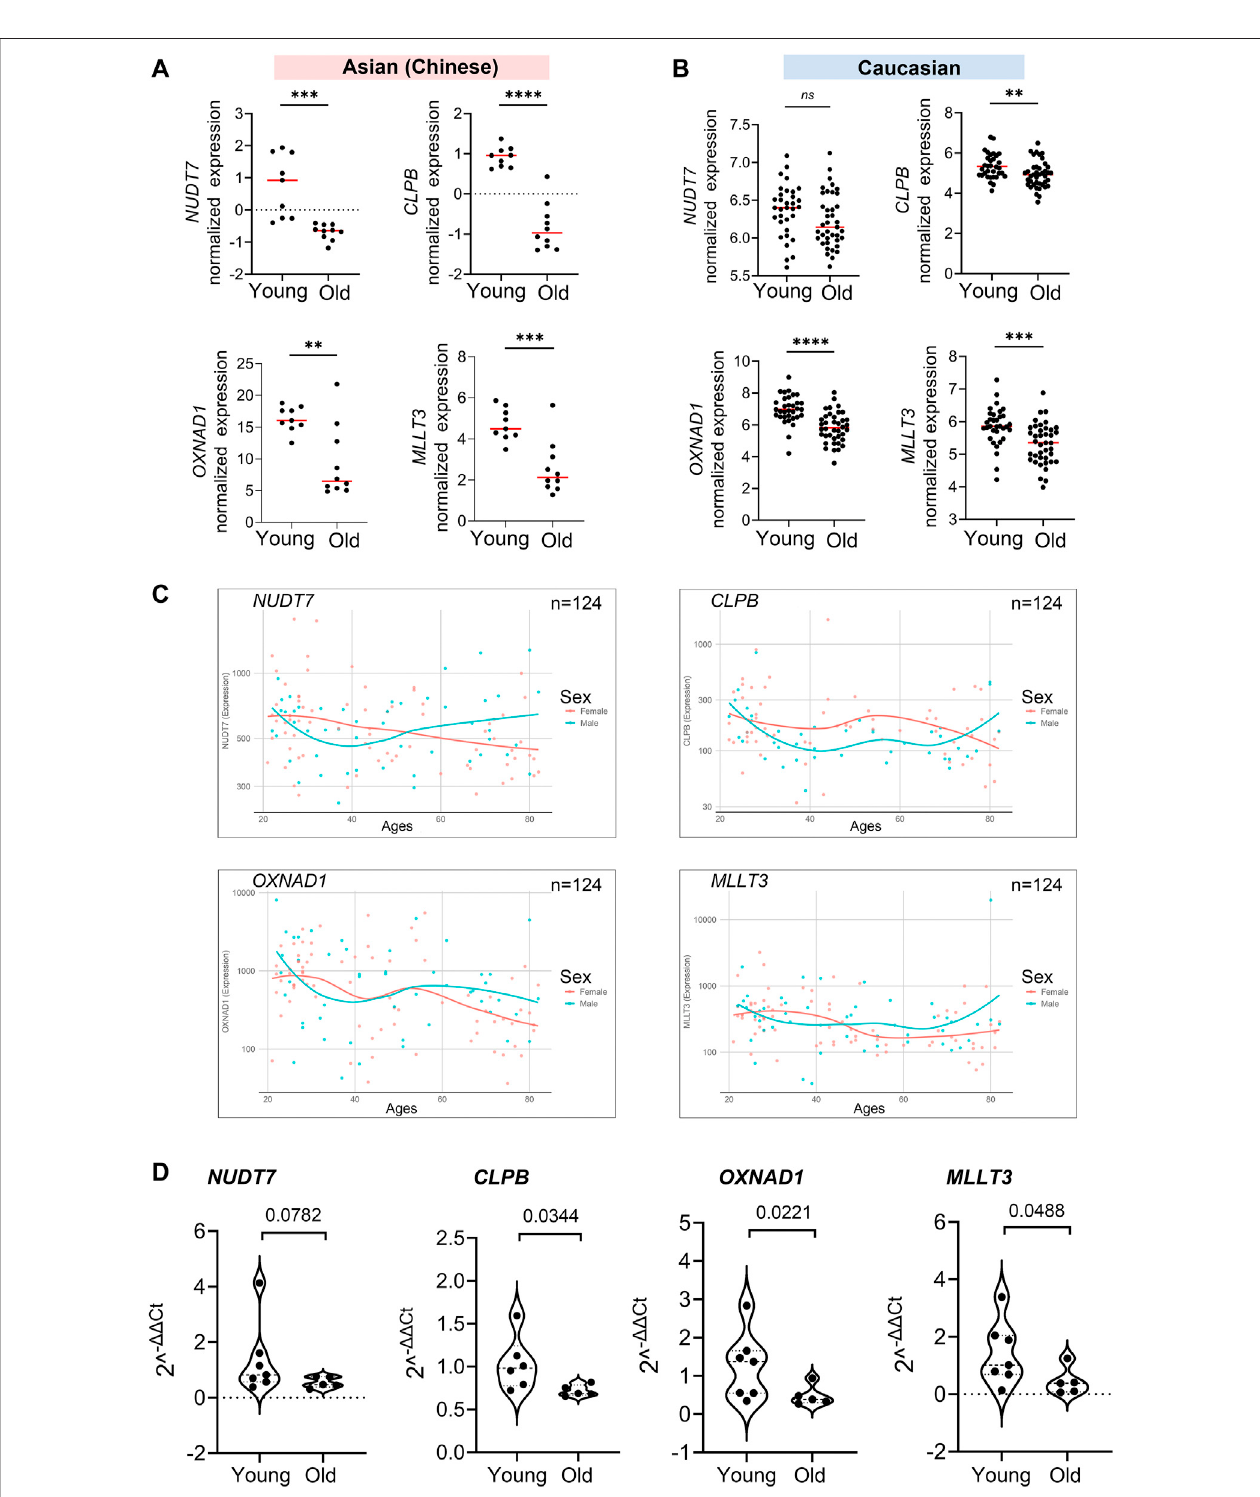
FIGURE 7 | Validation of expression levels of the common hub genes involved in PBMC aging. The validation in Asian (Chinese) and Caucasian was performed using additional samples and 10KIP data, respectively. (A,B) Gene expression value of the hub genes among young and old samples in 19 Asian (Chinese) (A) and 153 Caucasian (B) . The data were expressed as the mean ± standard deviation (SD). Student ’ s t-test was used for statistical analyses. In Asian (Chinese), young n (cid:1) 9, old n (cid:1) 10; in Caucasian, young n (cid:1) 33, old n (cid:1) 40, * p < 0.05, ** p < 0.01, *** p < 0.001,**** p < 0.0001. (C) Gene expression ofhubgenesamong samplesofmanand womanduringtheirlifespan, n (cid:1) 124,including19Asianand105Caucasian. (D) Quanti fi cationofthefourhubgeneswascon fi rmedandpresentedbytheqPCRassay.The data were expressed as the mean ± standard deviation (SD). The p -value was calculated by the student ’ s t-test. Young n (cid:1) 7; old n (cid:1) 5, * p < 0.05, ** p < 0.01.